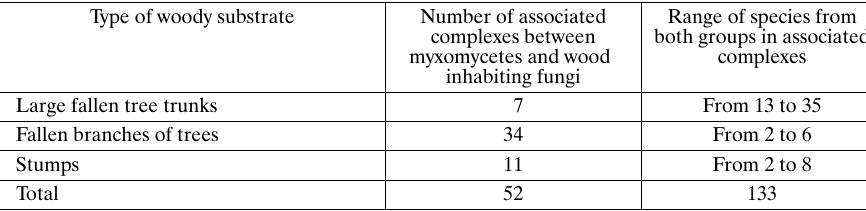
Distribution of associated complexes between myxomycetes and xylotrophic fungi on the different types of woody